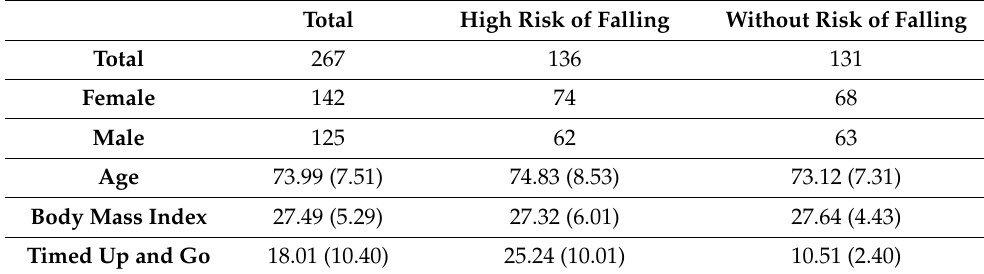
Table 1. Participant